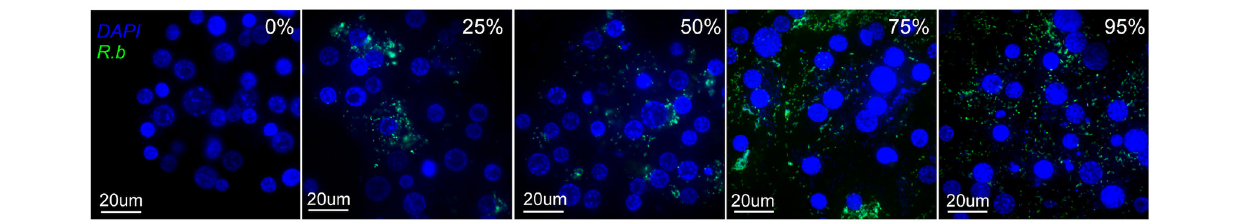
FIGURE 2 | Images of IRE11 cells with different levels of R. buchneri- GFPuv infection. Live IRE11 cells were stained with NucBlue Live ReadyProbes Reagent (Hoechst 33342; Invitrogen) and spun onto slides with a Cytospin centrifuge, following Wang et al. ( 81). Images were captured on an Olympus BX61 DSU Confocal Microscope using a × 60 objective and a double-wavelength filter (DAPI; FITC). DNA shown in blue, GFPuv shown in